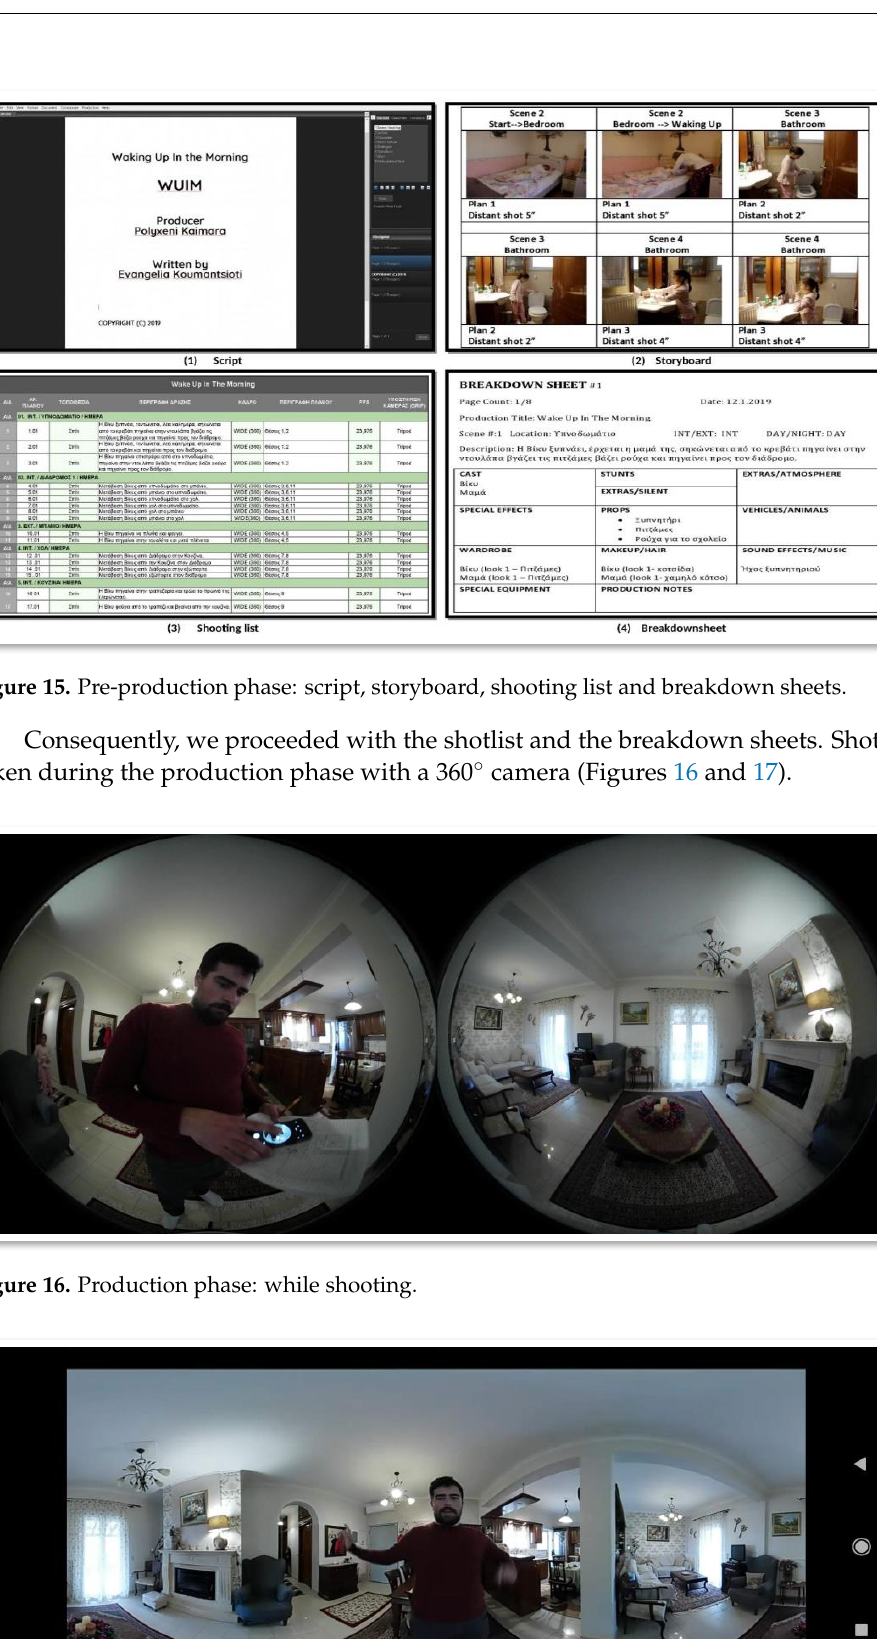
( b ) Figure 18. Post-production phase: Video converting for AR application ( a ) 360 ° video; ( b ) Standard video scheme 19. Post-production phase: Subtitle editing. Subtitling while the pedagogical agent speaks (Greek subtitle: Τι να κάνει η Βίκυ τώρα; English translation: What should Vicky do now? ).